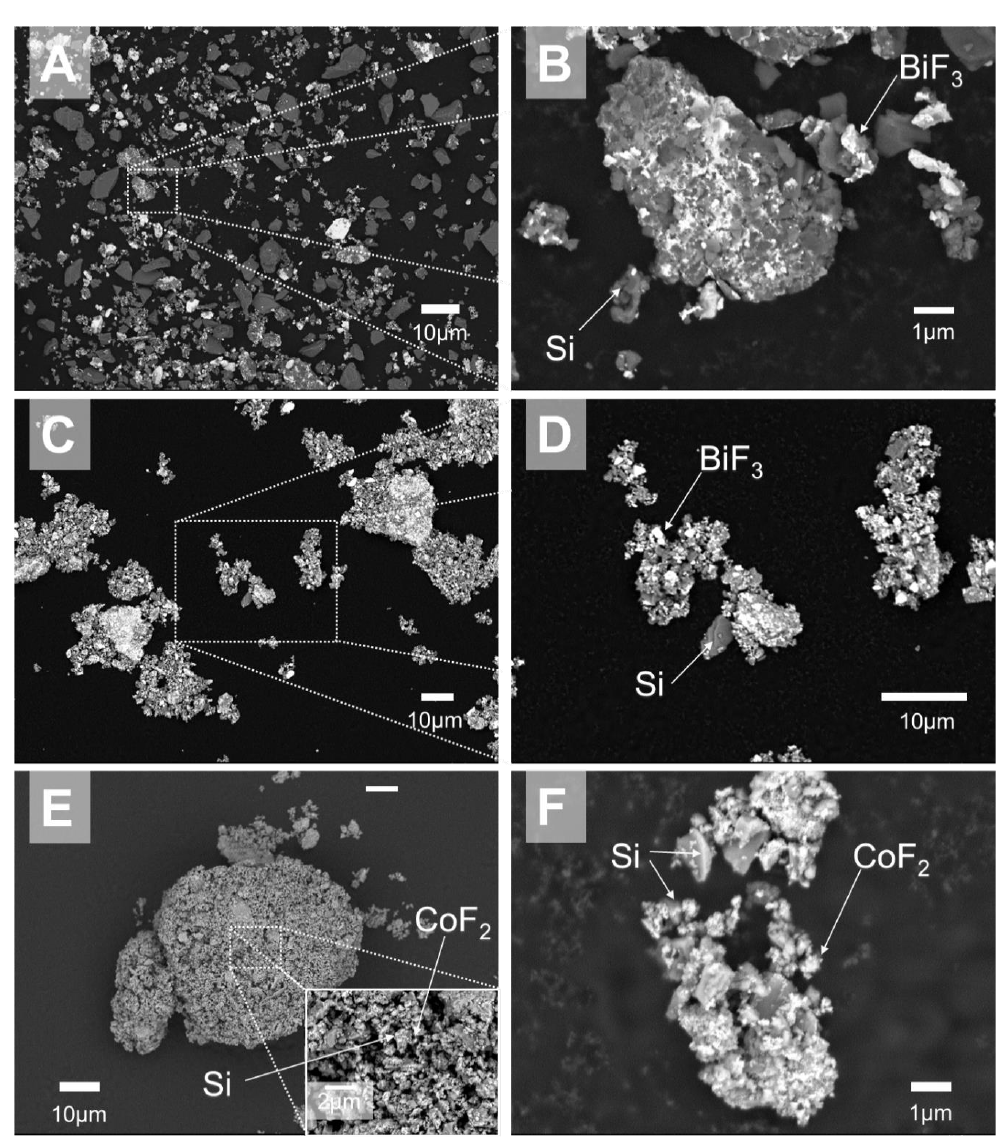
Figure 1. Backscattered electron images of as-milled 50 wt.% silicon-50 wt.% fluoride composites: ( A , B ) 1-stage 50Si · 50BiF 3 , ( C , D ) 50Si · 50BiF 3 and ( E , F ) 50Si · 50CoF 2 .